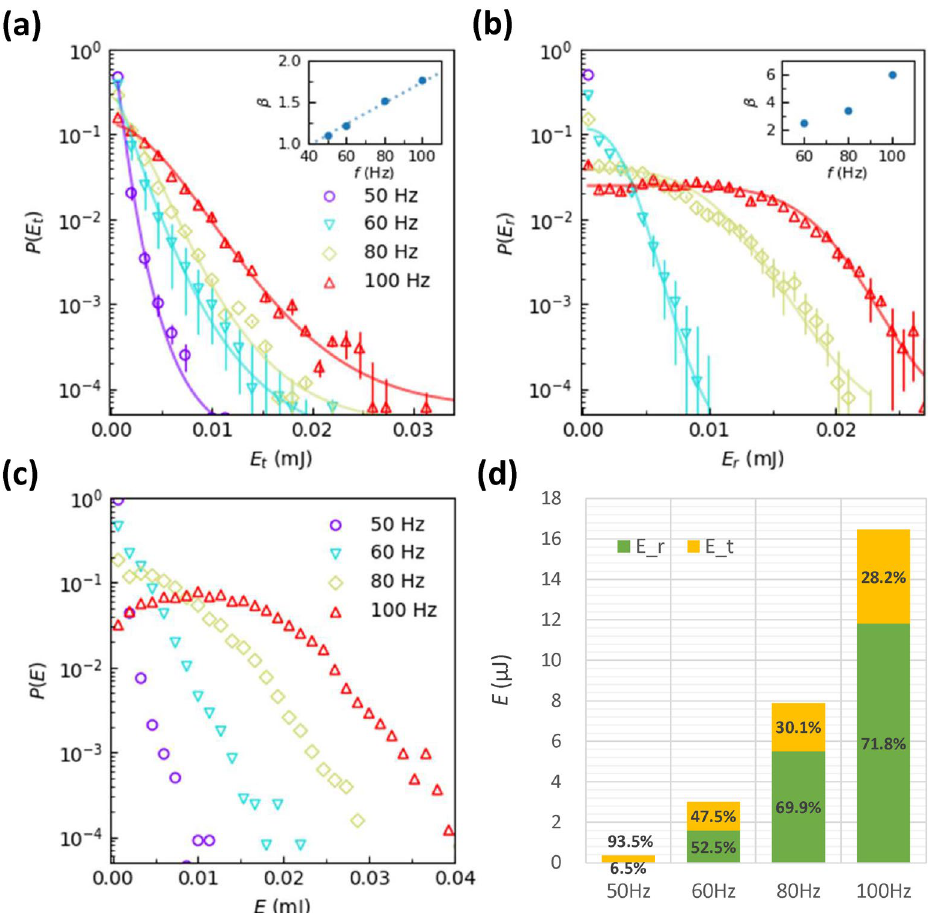
Ae − Bx β = 50 Hz, 60 Hz, 0.6 mm. f = =